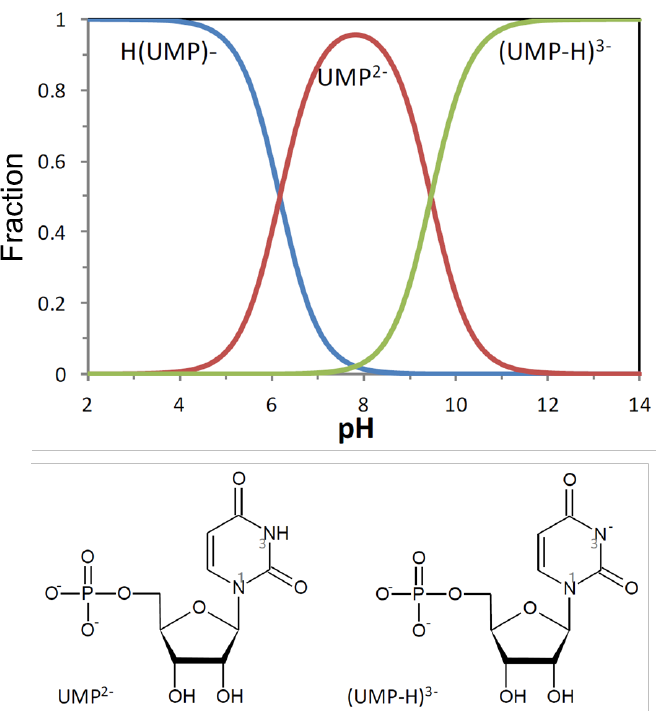
Figure 1. Fraction of aqueous uridine- 5’ monophosphate (UMP) ions ( upper ) and their structures ( lower ). Uracil moiety of aqueous UMP in this experiment takes the canonical form (left, lower) at pH = 7.5 and the deprotonated form at the N3 atom (right, lower) at pH = 11.3 (see text).